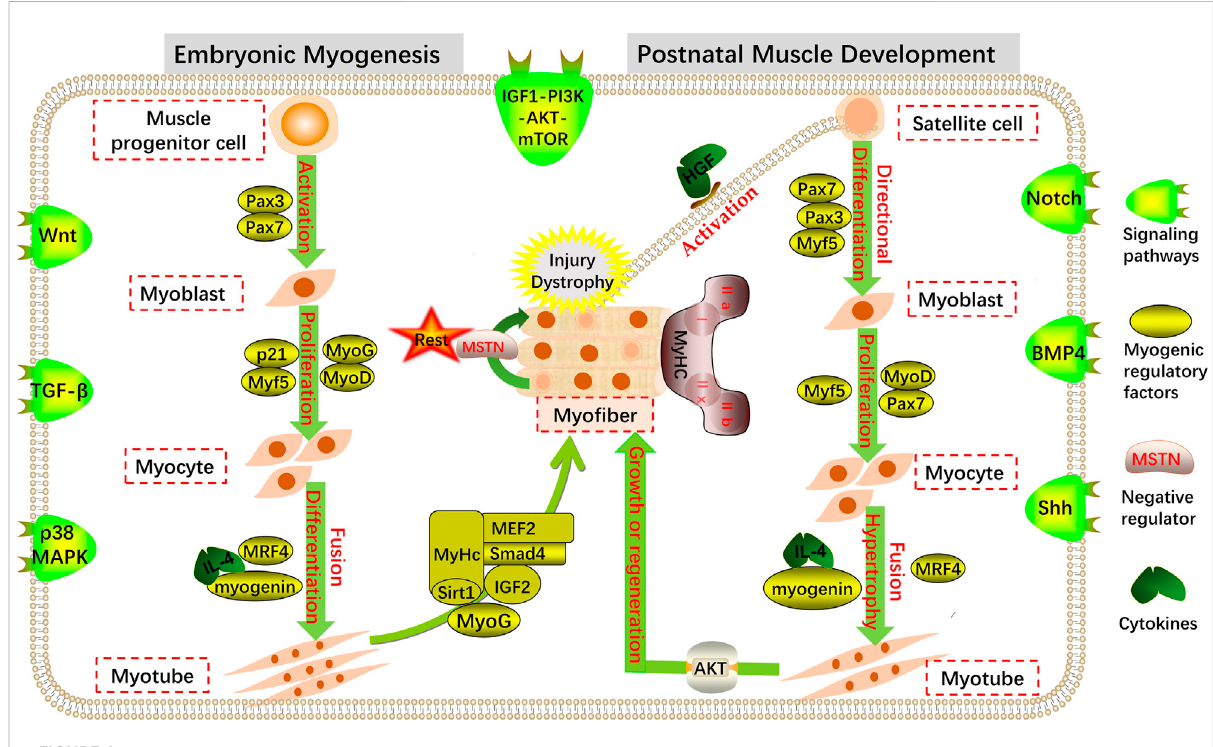
FIGURE 1 Regulation of myogenesis. Coordinated expression of multiple transcription factors and signaling pathways at different stages of embryonic myogenesis and postnatal muscle development maintain the dynamic balance of muscle cell proliferation and differentiation.